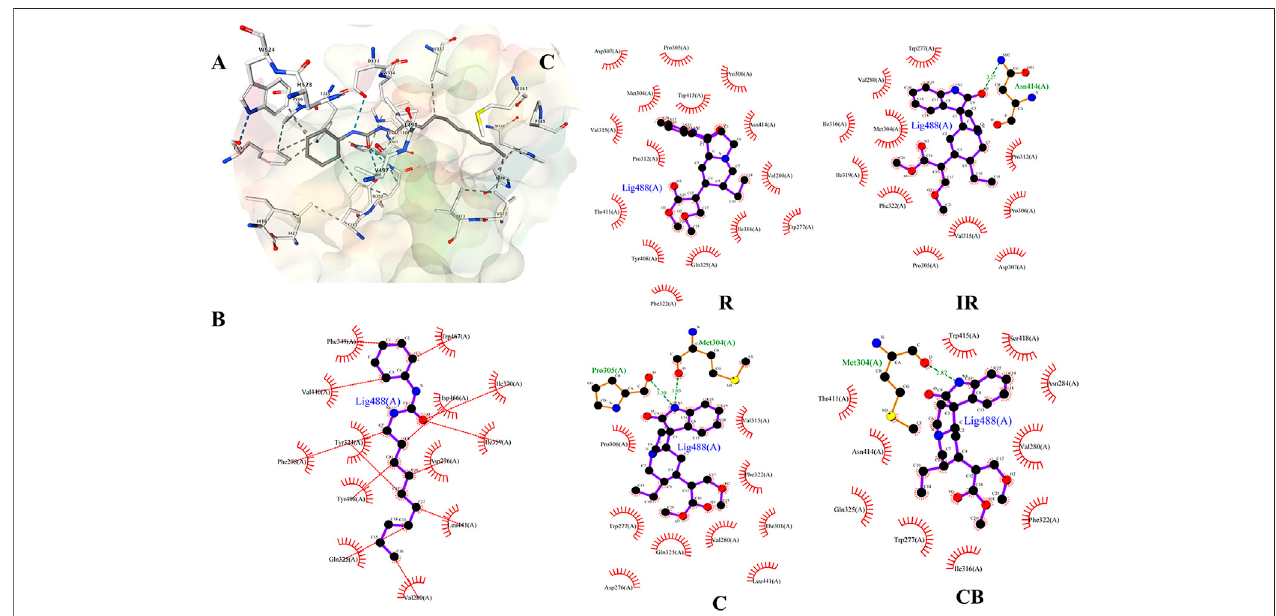
FIGURE 4 | (A) Docking diagram of components and protein molecules. The binding pattern between sEH protein and ligand CDU; (B and C) were 2D-docking poses. (B) The binding pattern between sEH protein and ligand CDU; (C) The binding pattern between R, IR, C, CB and sEH protein. Black dots: carbon atoms; blue dots: nitrogen atoms; red dots: oxygen atoms; green dotted lines: hydrogen bonds; red combs: amino acid residues.